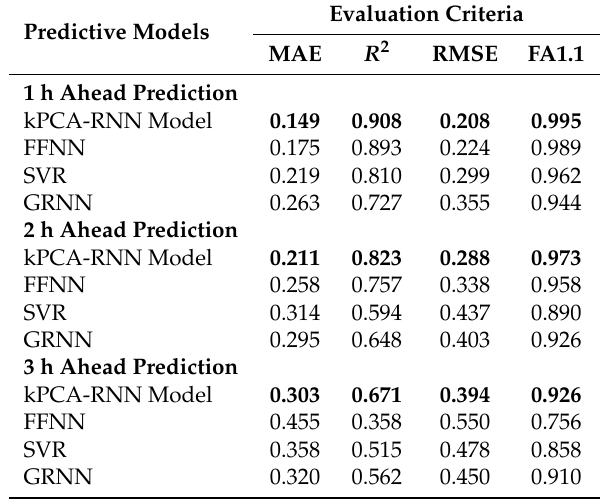
Table 4. Performance comparison with the FFNN, SVR and GRNN. Predictive